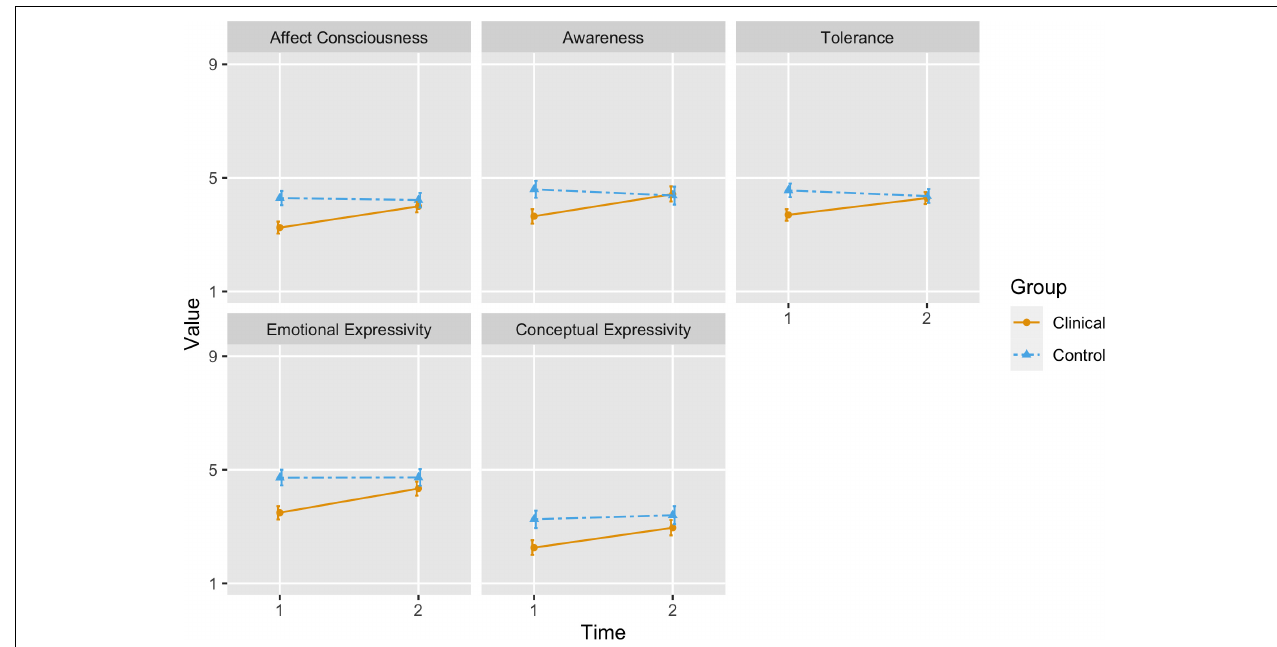
FIGURE 2 | The orange (solid) line represents the change in estimated marginal means for affect integration scores in the children with internalizing difficulties from time 1 to time 2, while the blue (dashed) line represents changes in affect integration in the control group. The bars represent 95 percent confidence intervals.